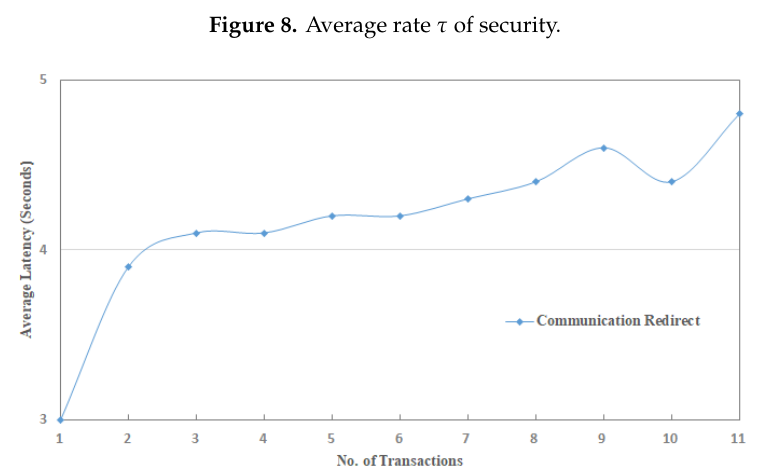
Figure 9. Average latency for communication redirect.